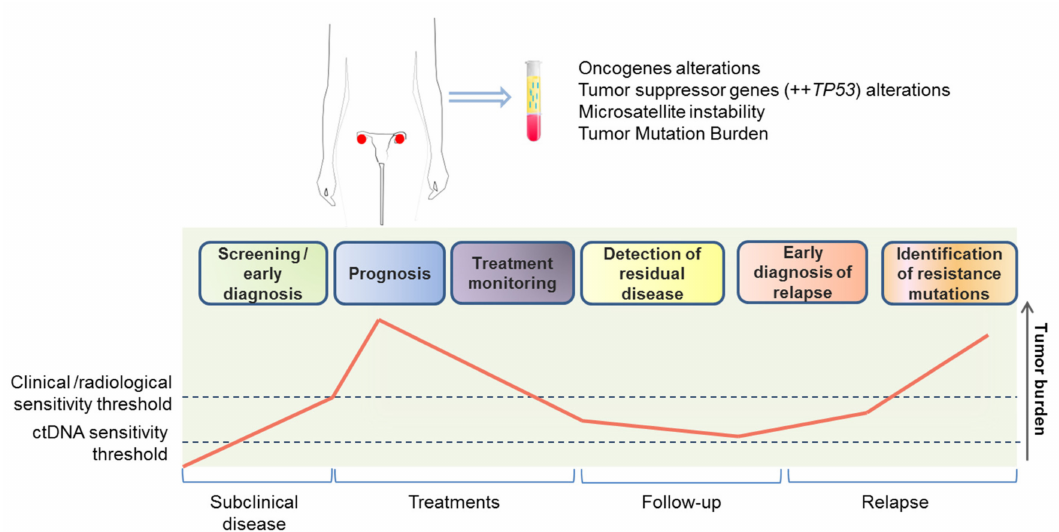
Figure 1. Circulating tumor DNA applications for ovarian cancer management. Detection and monitoring of genomic alterations with approved therapies or phase 2 / 3 clinical trials available ( top ). Potential use of circulating tumor DNA for various clinical settings ( bottom ); inspired from